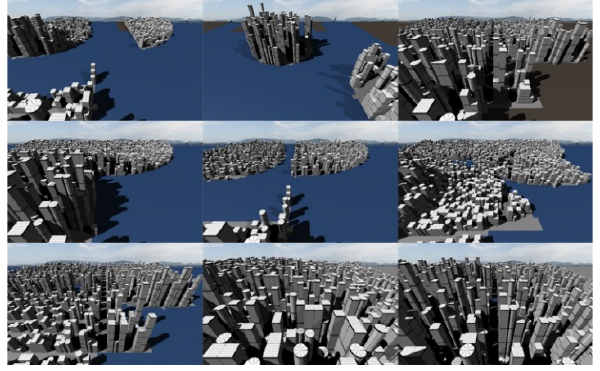
Figure 6. Generation 10 of an IGA run